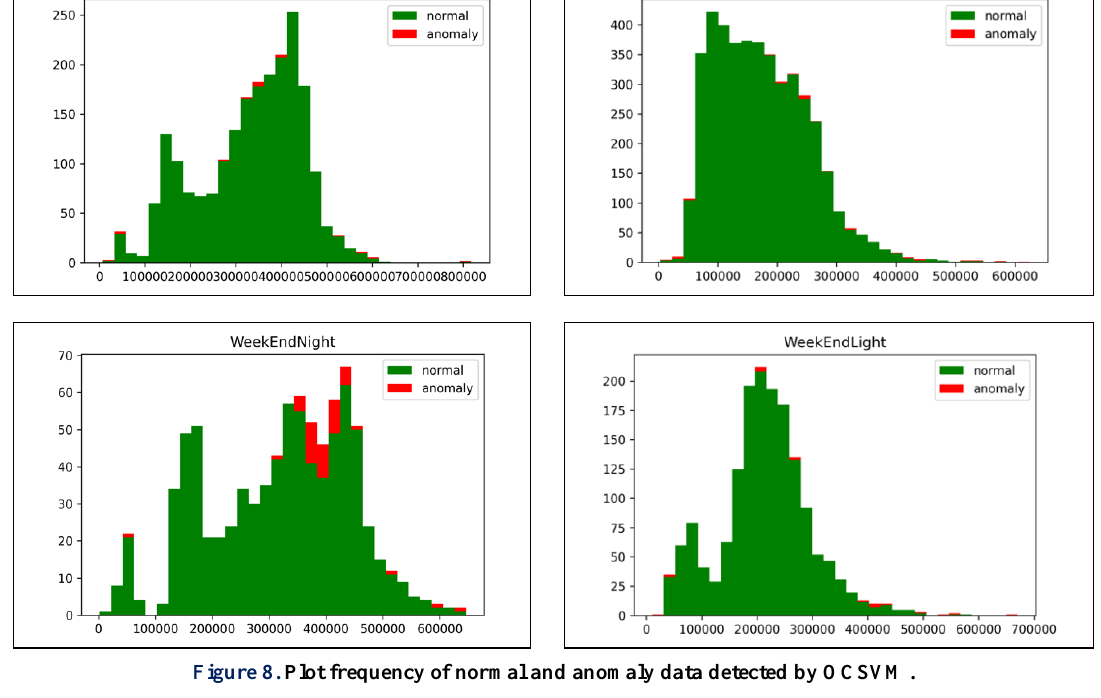
Figure 8. Plot frequency of normal and anomaly data detected by OCSVM.